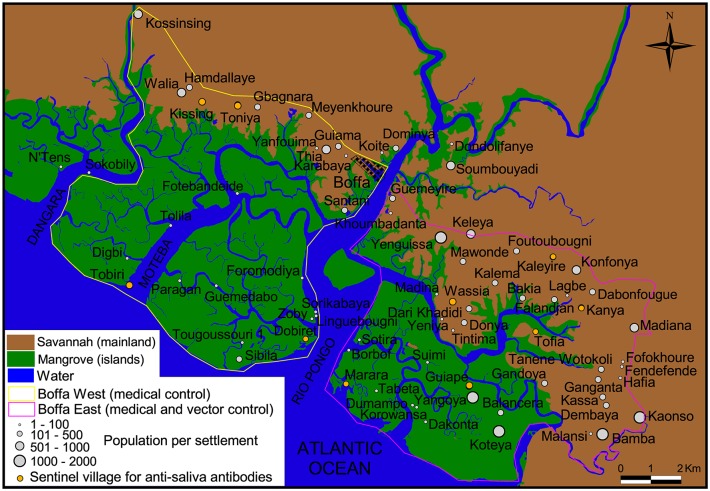
Map of the study area indicating the location of settlements.